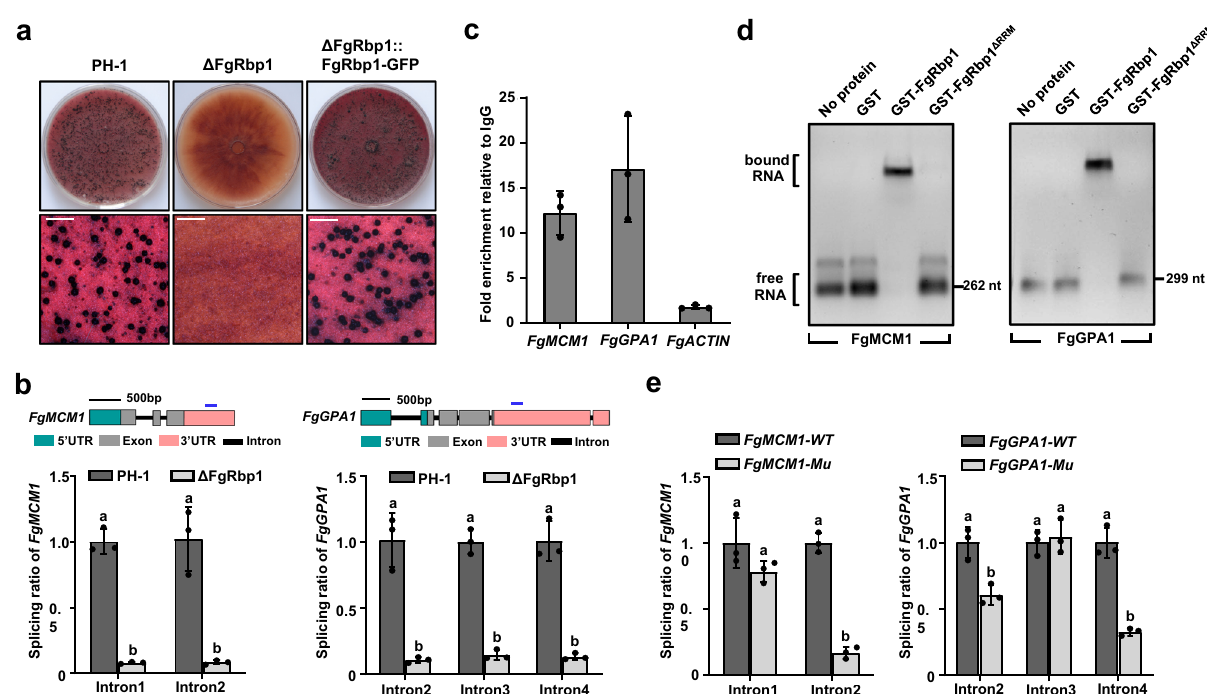
Fig. 6 FgRbp1 is required for sexual reproduction in F. graminearum via regulating the splicing of mating-related genes. a Deletion of FgRbp1 leads to sexual sterility. Each strain was grown on carrot agar for induction of perithecial formation. Bar = 500 µ m. b qRT-PCR validation of the splicing defect of introns in FgMCM1 and FgGPA1 . The schematic of FgMCM1 or FgGPA1 is shown at the top. The blue solid line denotes the binding peak identi fi ed in RIP-seq. c Veri fi cation of FgRbp1 binding on mRNAs of FgMCM1 and FgGPA1 by RIP-qPCR. ACTIN served as a control. Error bars represent means ± SD of three repeated experiments. d EMSA con fi rmation of the direct binding of FgRbp1 to the RNAs of FgMCM1 or FgGPA1 . In vitro transcribed RNAs containing the peak sequence of FgMCM1 or FgGPA1 were incubated with GST-fusion proteins described in Fig. 4b. e Deletion of the binding fragments in b resulted in decreased intron splicing ratio of introns in FgMCM1 or FgGPA1 . The wild-type PH-1 strains contain the peak fragment while Mu strains are deleted with the peak fragments. In b and e , bars represent means ± SD ( n = 3 biologically independent replicates). Different letters indicate a signi fi cant difference ( P < 0.05) according to the two-tailed unpaired Student ’ s t